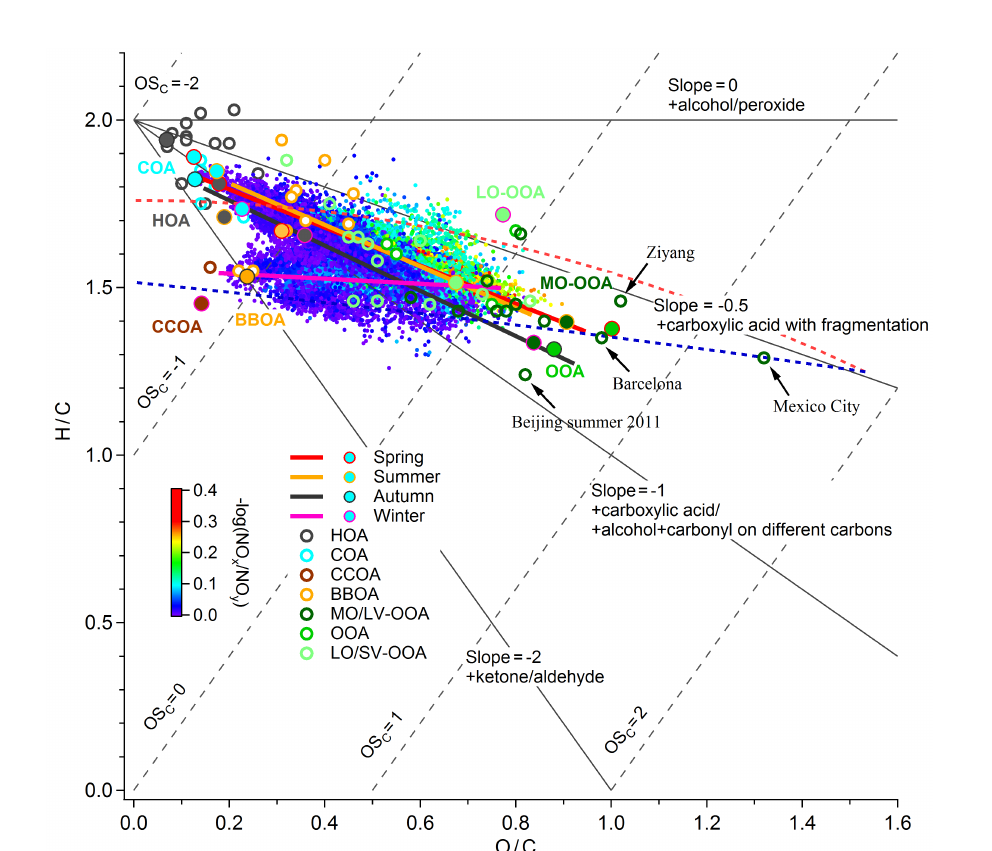
Figure 8. Tri-VK-OS C diagram based on seasonal observations. The scatterplot of H / C vs. O / C ratios is colored by the parameter − log(NO x / NO y ) . The OA factors resolved by the AMS-PMF analysis are also marked in the diagram. The majority of the data fall within the dashed red and blue lines (Ng et al., 2011). Improved-ambient results for OA factors are from Hu et al. (2016a, b) and the summarization of Canagaratna et al.